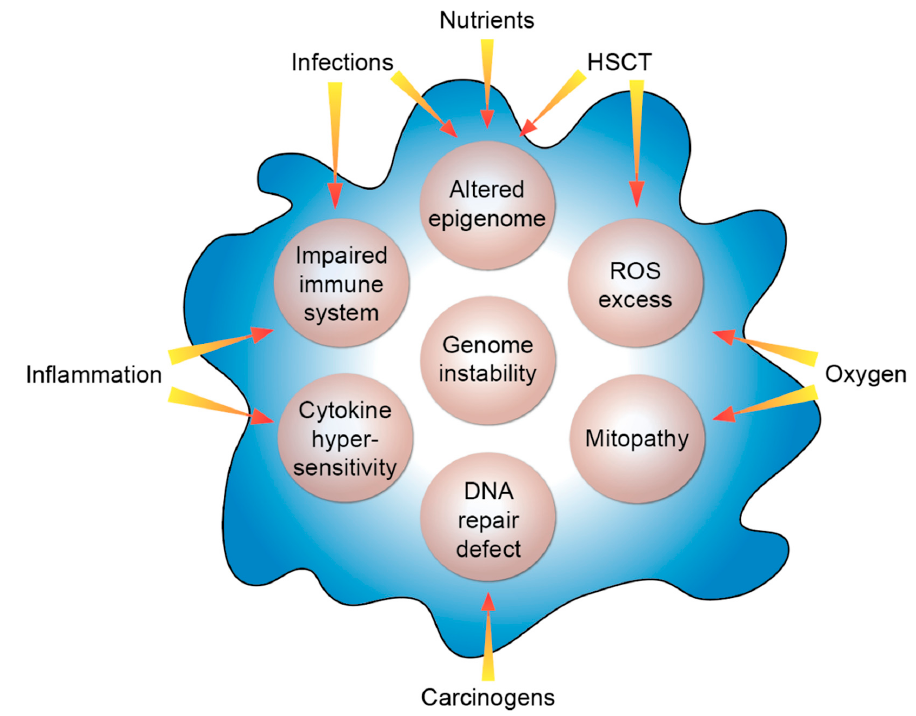
Figure 2. Molecular features of FA. The listed intrinsic processes (beige circles) are modulated by the indicated extrinsic factors. HSCT, hematopoietic stem cell transplant; ROS, reactive oxygen species. The different clinical presentations of FA patients point out that a number of extrinsic modifiers